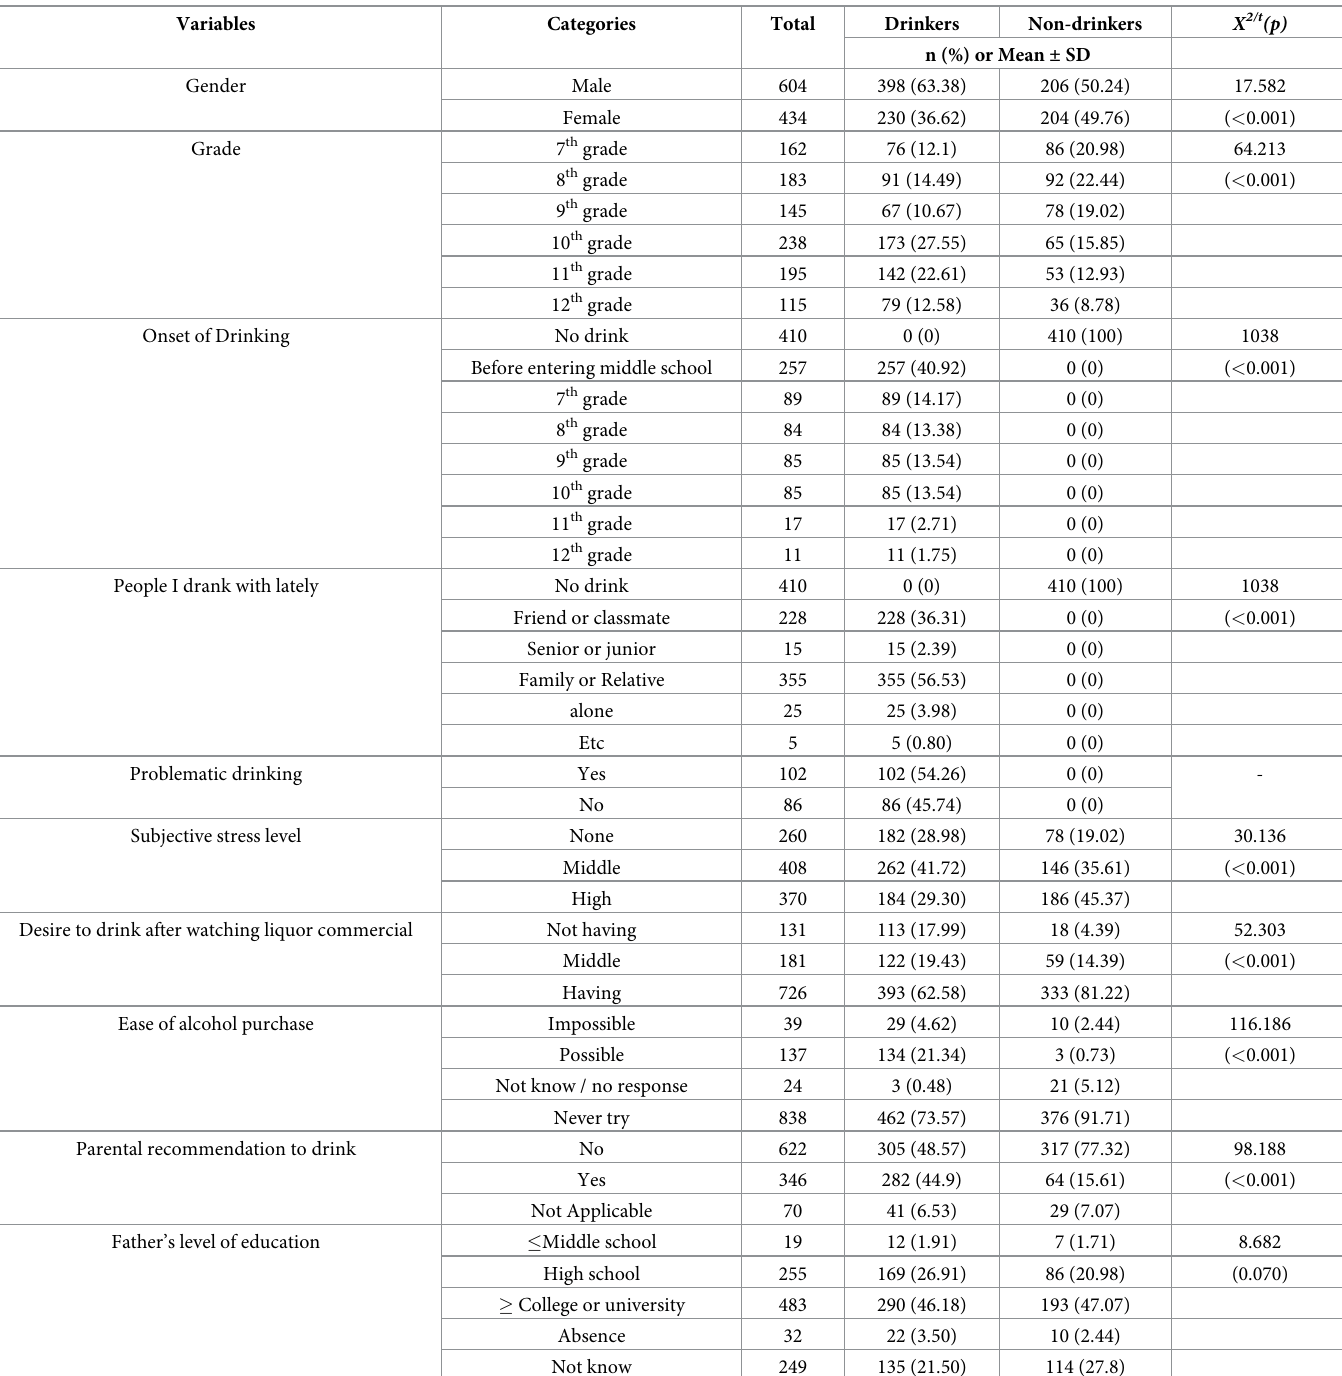
Table 1. Characteristics and differences between drinkers and non-drinkers in adolescents. (N =